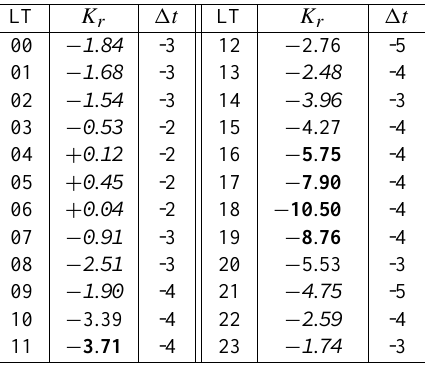
to practically one curve (Fig. 3, right-hand, bottom). The